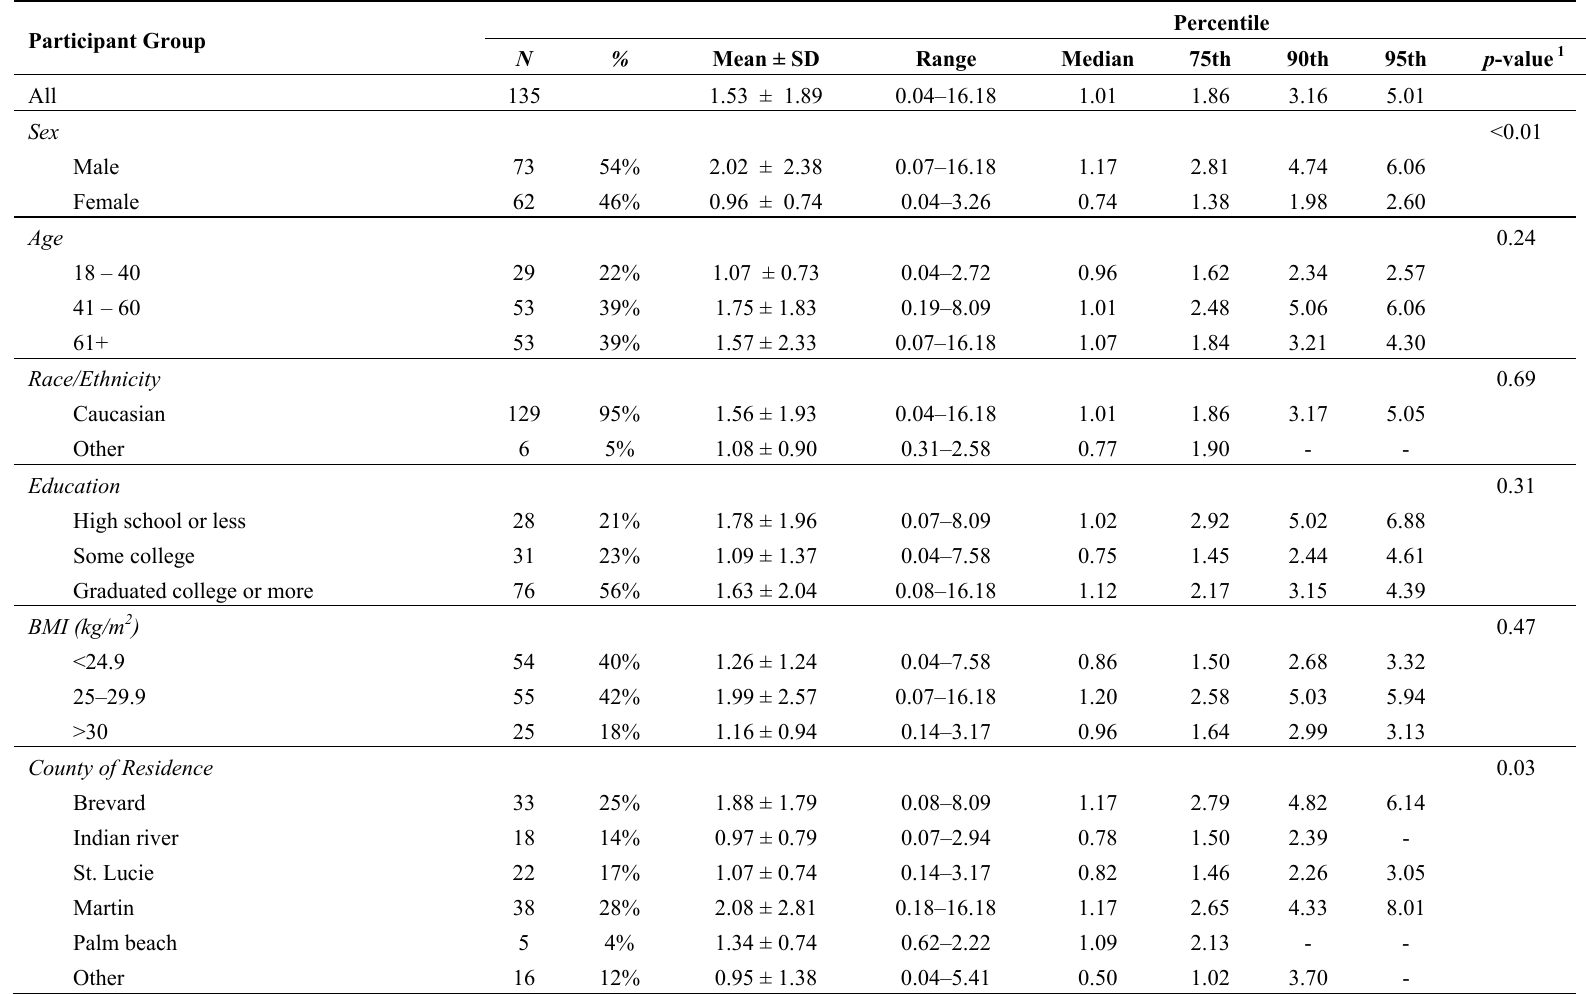
Table 1. Total hair mercury concentration (µg/g) by demographic and fish consumption variables, Florida